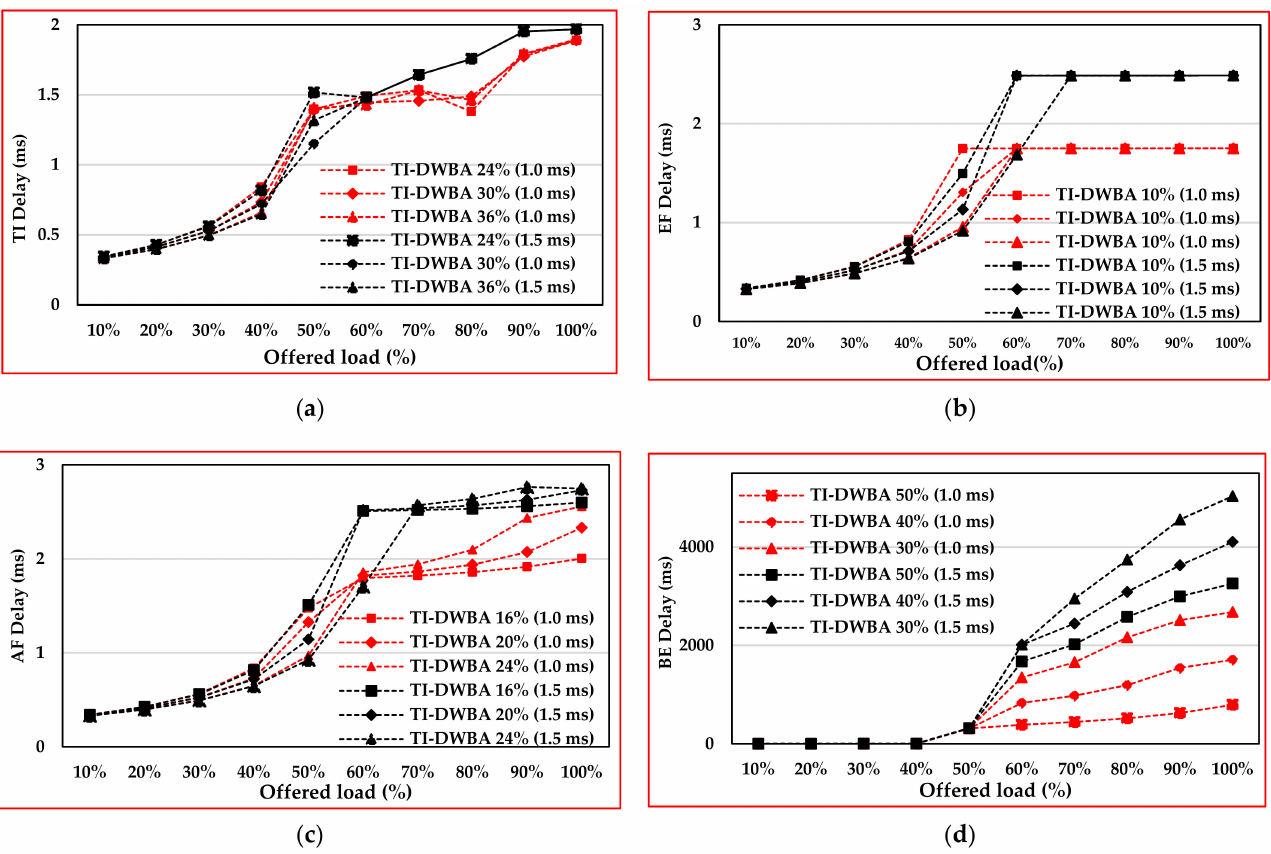
Figure 7. Mean packet delay comparison in different scenarios in ( a ) TI Delay, ( b ) EF Delay, ( c ) AF Delay, ( d ) BE Delay, 1.0 and 1.5 (ms) cycle